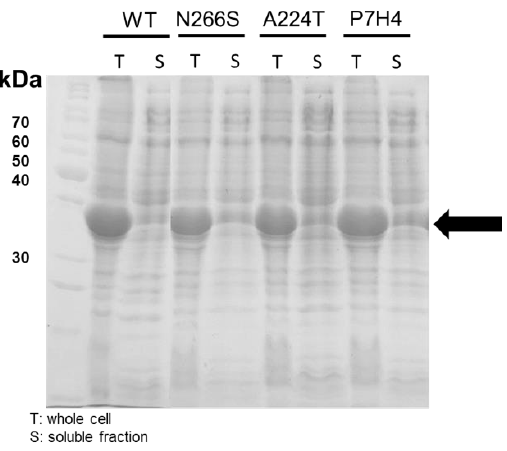
Figure 2. The expression of OxdYH3-3 wild type (WT) and its mutants. Overexpressed proteins under cultivation in an autoinduction medium was disrupted and separated into total and soluble protein following analysis by electrophoresis. The first lane was a protein size marker corresponding the number on the left side. The sizes of OxdYH3-3 WT and mutants were approximately 41.3 kDa (arrow). T, total protein; S, soluble protein.